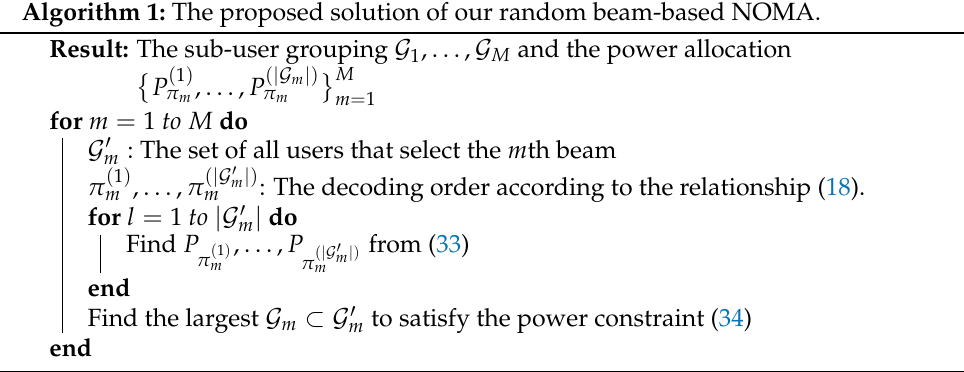
Algorithm 1: The proposed solution of our random beam-based